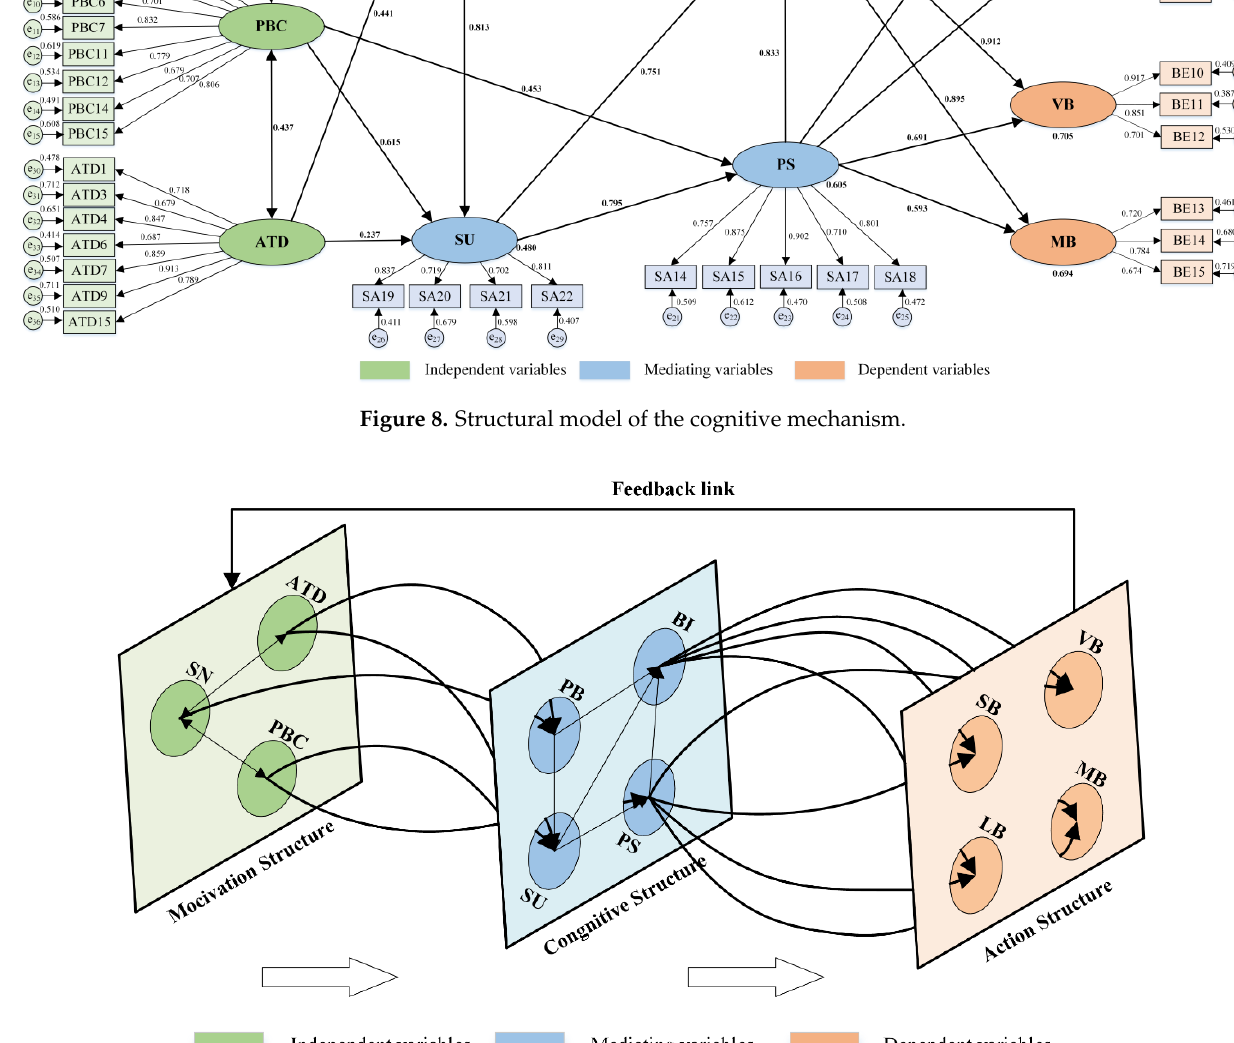
Figure 9. The motivation–cognition–action–feedback (MCAF) cognitive mechanism of pilots’ unsafe behaviors.